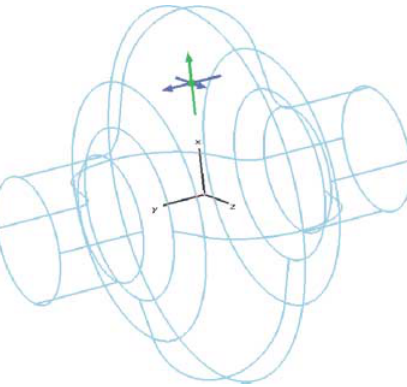
FIG. 3. (Color) Virtual pickup antennas for field components in the inner cavity volume.